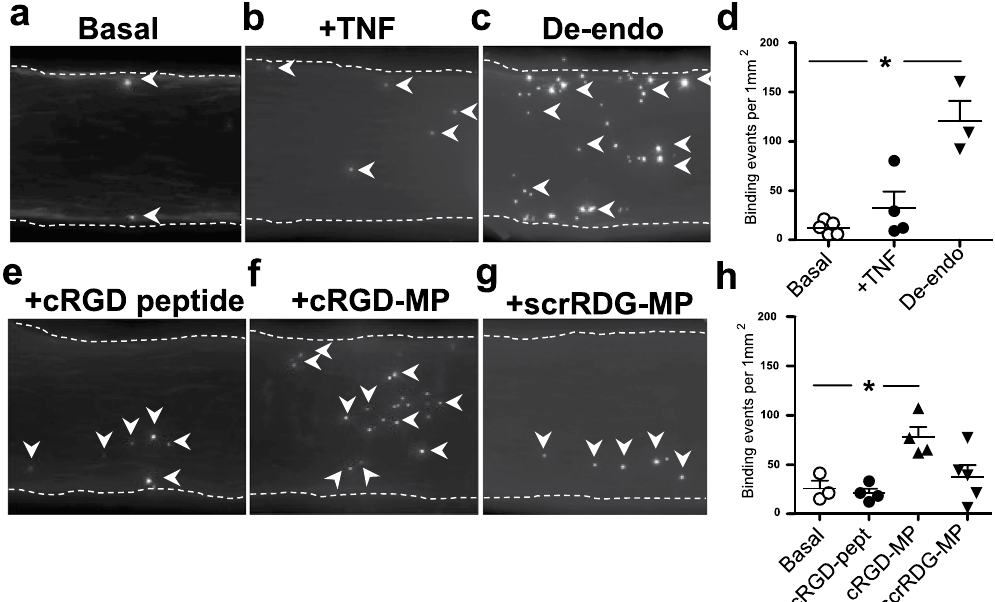
Figure 3. Platelet adhesion is facilitated by synthetic RGD-MPs in the cerebral artery. Fluorescence images of representative time-lapse recording demonstrate firm binding of CFSE-labelled platelets on the luminal surface of the isolated mouse MCA in the presence of physiological pressure and flow (white arrowheads show stationary platelets). ( a–d ) Platelet adhesion was measured under flow in the absence (basal) or presence of TNF (7 ng/ml, 4-hour), and after the endothelium was removed with air (De-endo), as well as ( e–h ) in the presence and prior intraluminal loading with cRGD peptide (100 μ g/ml), cRGD-MPs or scrRDG-MPs (0.1 µ g/ml, each). Data are mean ± SEM; * p <